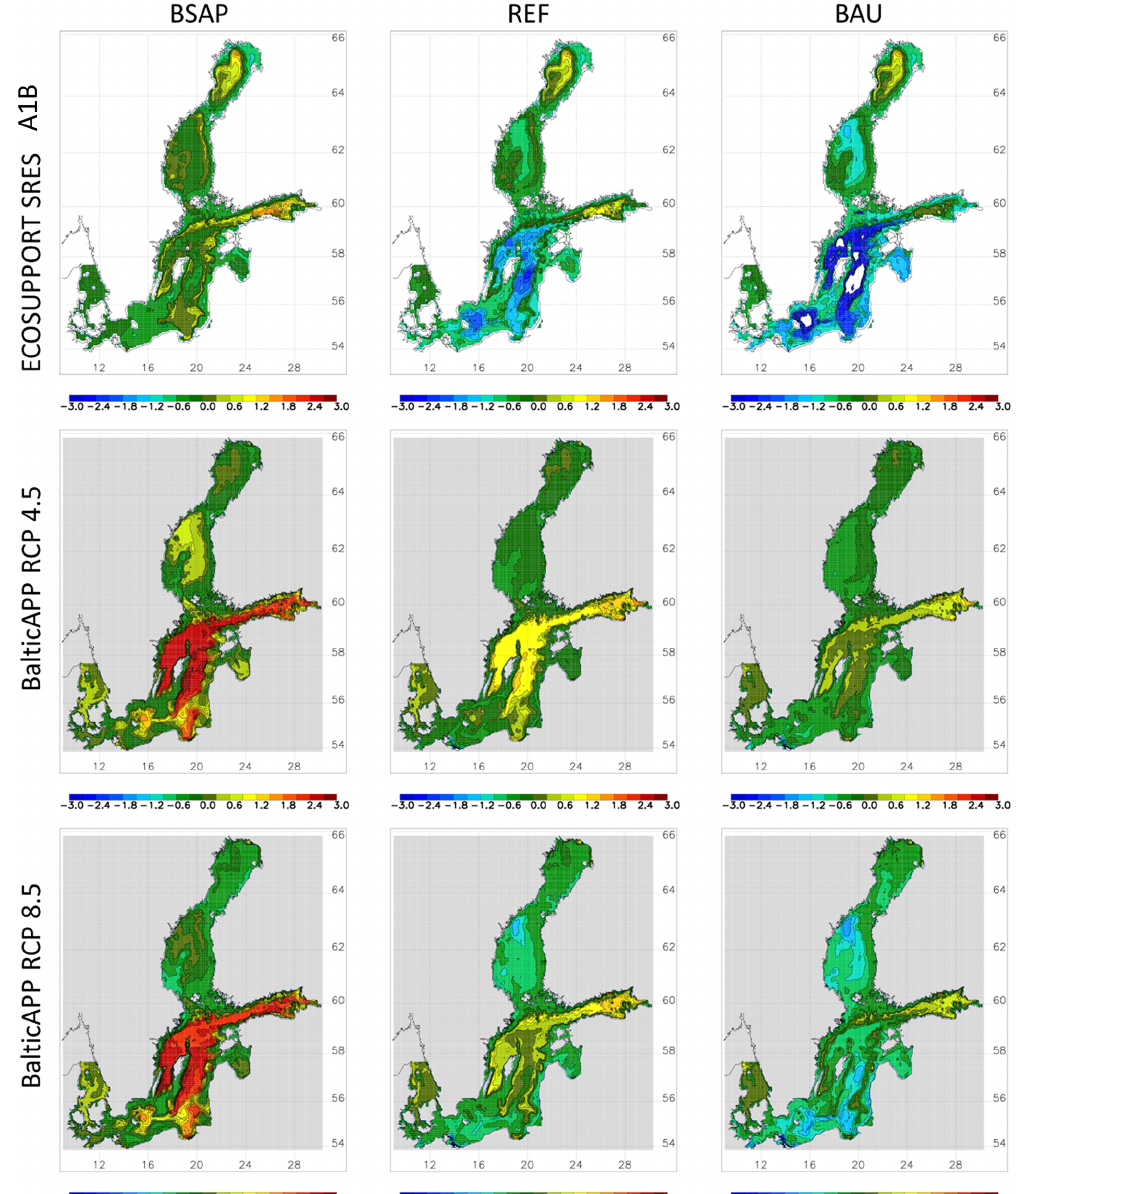
Figure 32. Ensemble mean summer (June to August) bottom dissolved oxygen concentration changes (millilitres per litre; hereafter mLL − 1 ) between 1978–2007 and 2069–2098. From left to right, the results of the nutrient load scenarios Baltic Sea Action Plan (BSAP), reference (REF), and business as usual (BAU) are shown. From top to bottom, the results of the ensembles by Meier et al. (2011a; ECOSUPPORT), under the A1B/A2 greenhouse gas emission scenario (white background), and by Saraiva et al. (2019b; BalticAPP), under RCP4.5 (grey background) and RCP8.5 (grey background), are depicted. Source: Meier et al.,